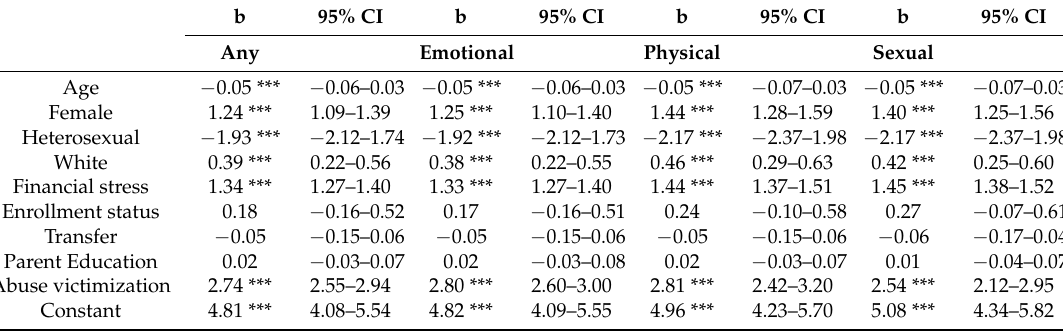
Table 2. Summary of linear regressions for the association between violence victimization and symptoms of general